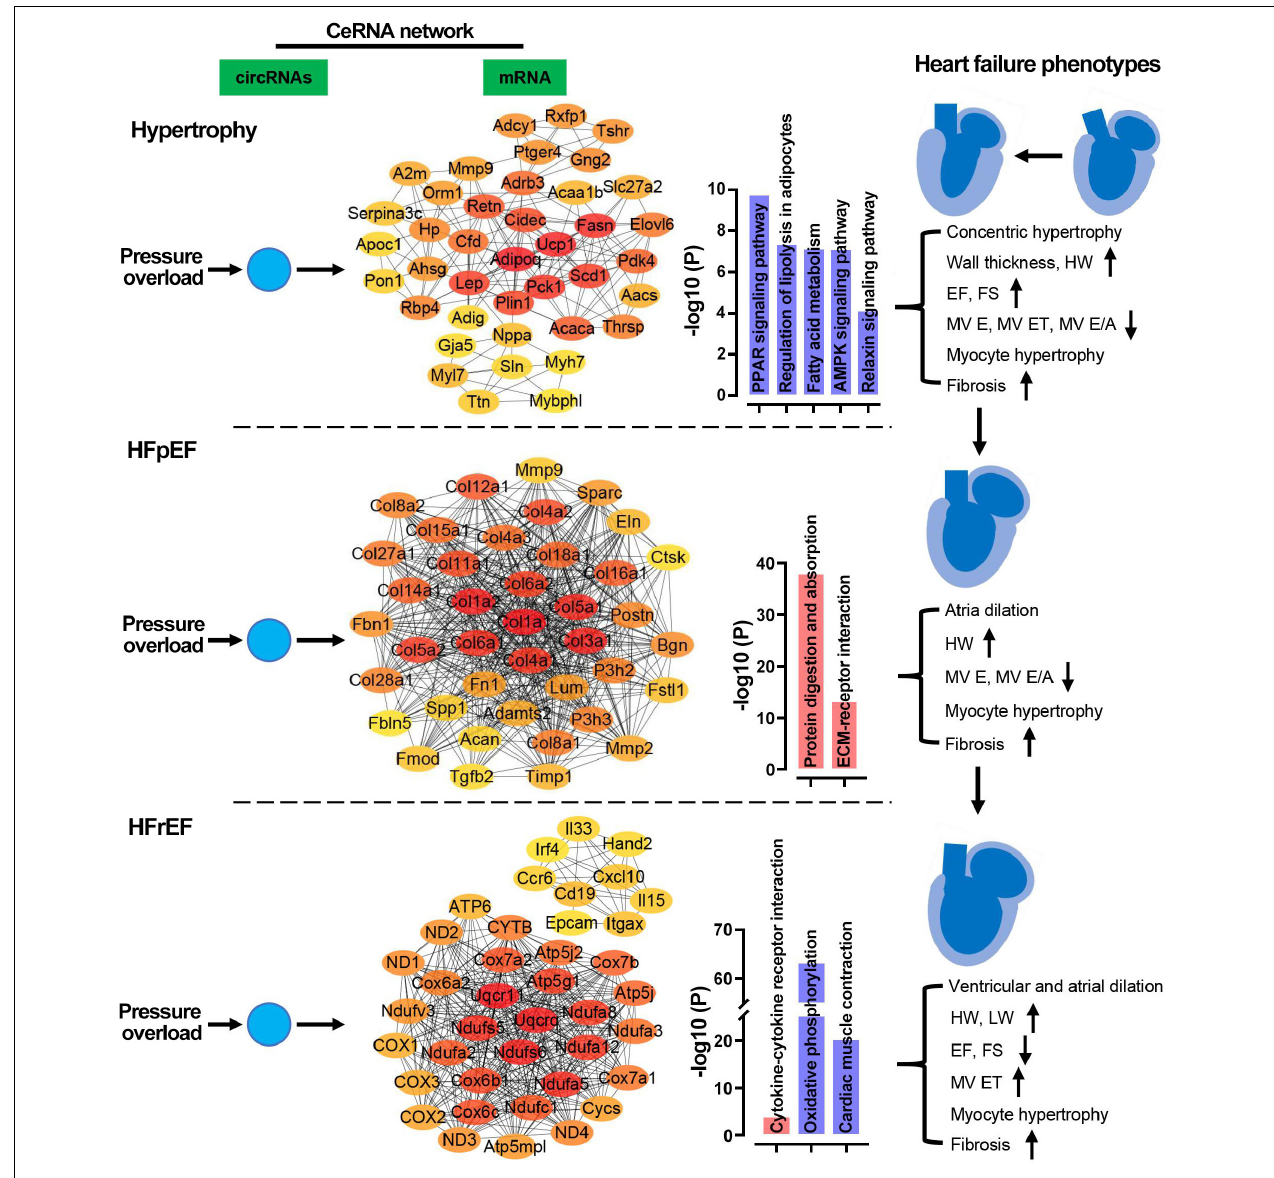
FIGURE 11 | Potential regulatory mechanisms of ceRNA networks in the three stages of heart failure. In the pressure overload hearts, circRNAs were predicted to regulate cardiac metabolism, remodeling, and mitochondrial function/cardiac contraction in hypertrophy, HFpEF, and HFrEF, respectively. HW, heart weight; LW, lung weight; EF, ejection fraction of the left ventricle; FS, fractional shortening; MV ET, ejection time of the left ventricle; IVCT, isovolumetric contraction time; IVRT, isovolumetric relaxations time; MV E/A, the ratio of peak E-wave to peak A-wave velocity from mitral inflow Doppler.